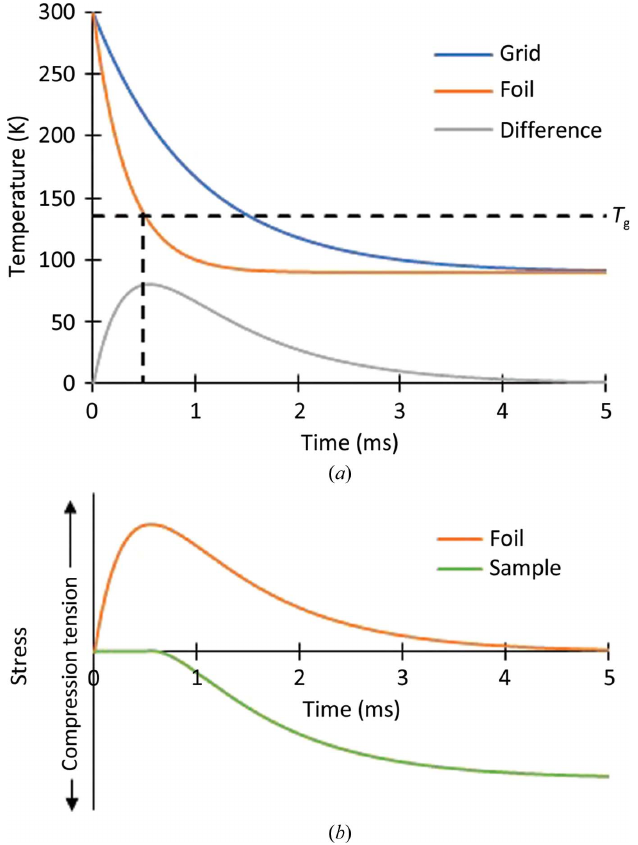
Figure 1 Temperature and stress during plunge-cooling of cryo-EM samples. ( a ) The grid cools more slowly than the foil and sample near the middle of the grid openings, so a large temperature difference between the grid and foil may transiently occur. ( b ) The transient temperature difference produces a transient tensile stress in the foil, the dimensions of which are constrained by those of the grid. The sample vitrifies and becomes strongly coupled to the foil only at T g , when the foil is under tensile stress. As the grid bars cool, the temperature difference between the grid bars and foil decreases and the tensile stress in the foil is released, the sample is placed under compressive stress. The grid and foil are here assumed to be of the same